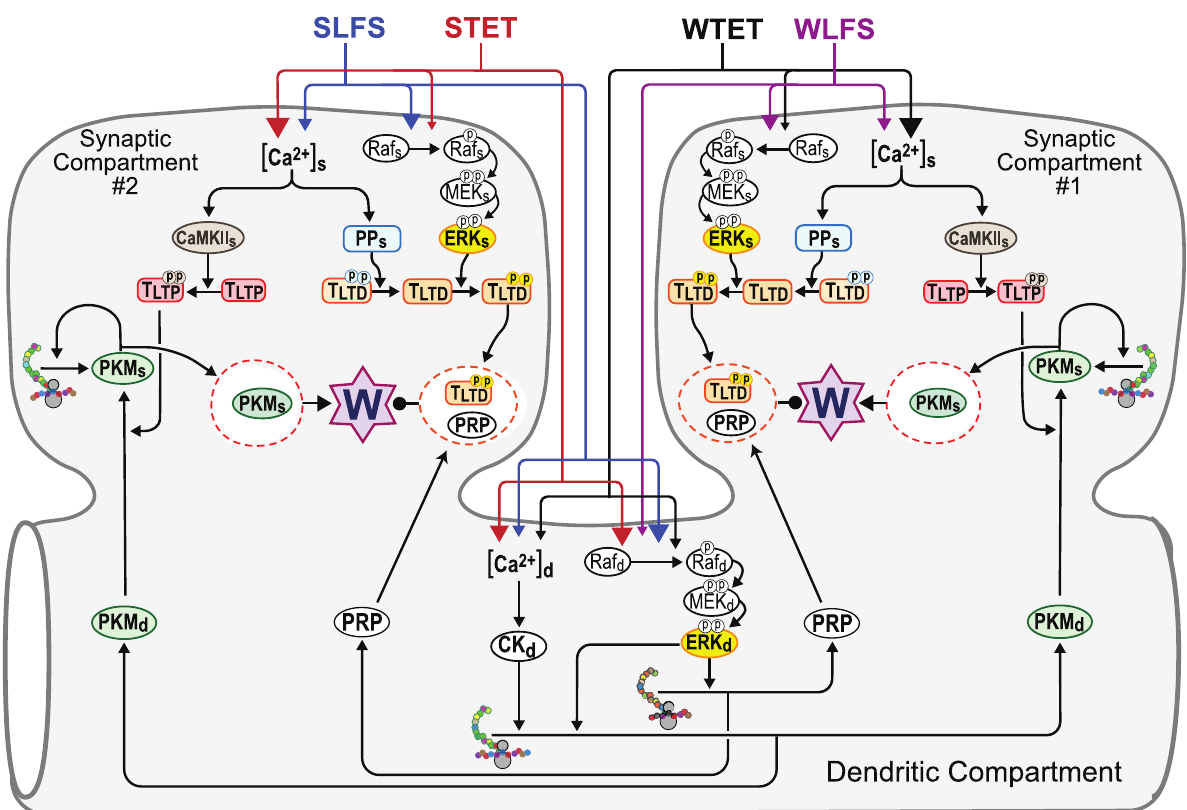
Figure 1. Schematic representations of two synaptic spines (Synaptic Compartments # 1 and # 2) and an adjacent dendrite (Dendritic Compartment). The biochemical cascades in Synaptic Compartments # 1 and # 2 are identical. Note, the model equations only represent a single synaptic compartment and a dendritic compartment. However, to better illustrate the effects of stimulus protocols, two synaptic compartments are illustrated. The two compartments represent, respectively, the response to weak vs. strong stimuli. The stimulus protocols are: i ) Strong low-frequency stimulus (SLFS); ii ) Strong tetanic stimulus (STET); iii ) Weak tetanic stimulus (WTET); and iv ) Weak low-frequency stimulus (WLFS). Stimuli increase levels of Ca 2 + ([Ca 2 + ] s and [Ca 2 + ] d ) and activate synaptic and dendritic ERK cascades (denoted, respectively, Raf s /MEK s /ERK s and Raf d /MEK d /ERK d ). Sizes of arrowheads reflect the impact that each protocol has on Ca 2 + levels and on ERK activation. The model includes three novel features. First, translation of dendritic PKM, PKM d , requires activity of ERK d and of a Ca 2 + -dependent kinase (CK d ). Second, PKM d can only be captured by a synaptic compartment if that synapse is tagged for LTP. Third, bistability and persistent activation of synaptic PKM, PKM s , occurs only in the synaptic